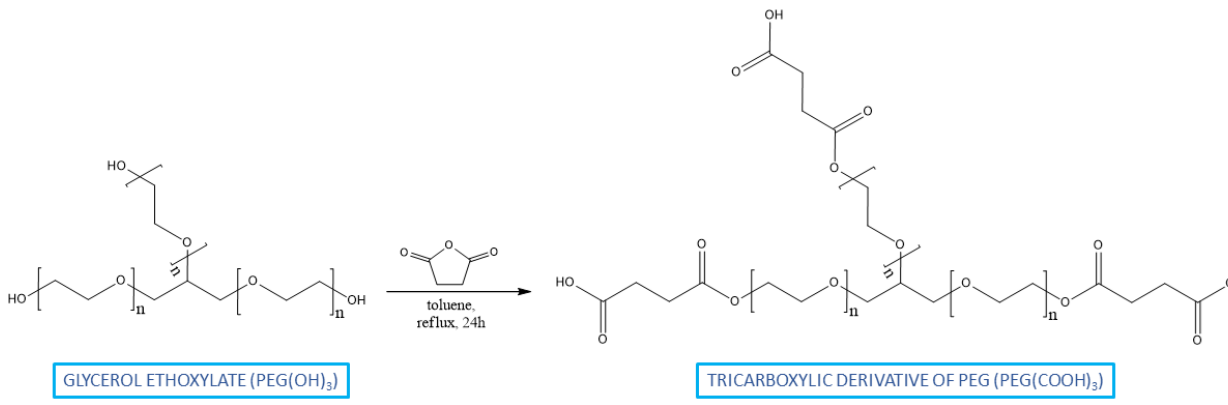
Figure 2. Reaction scheme for the modification of PEG.